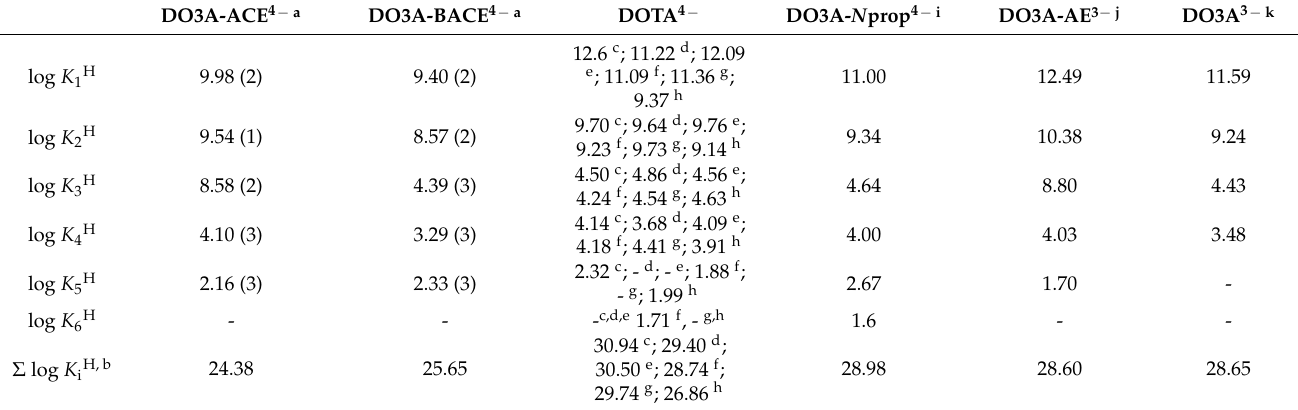
Table 1. Protonation constants of DO3A-ACE 4 − , DO3A-BACE 4 − , DOTA 4 − , DO3A 3 − , and DO3A- N prop 4 − at 25 ◦